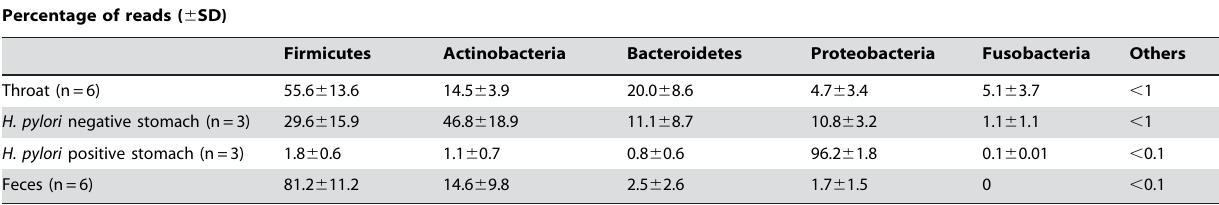
Percentage of reads ( 6 SD)